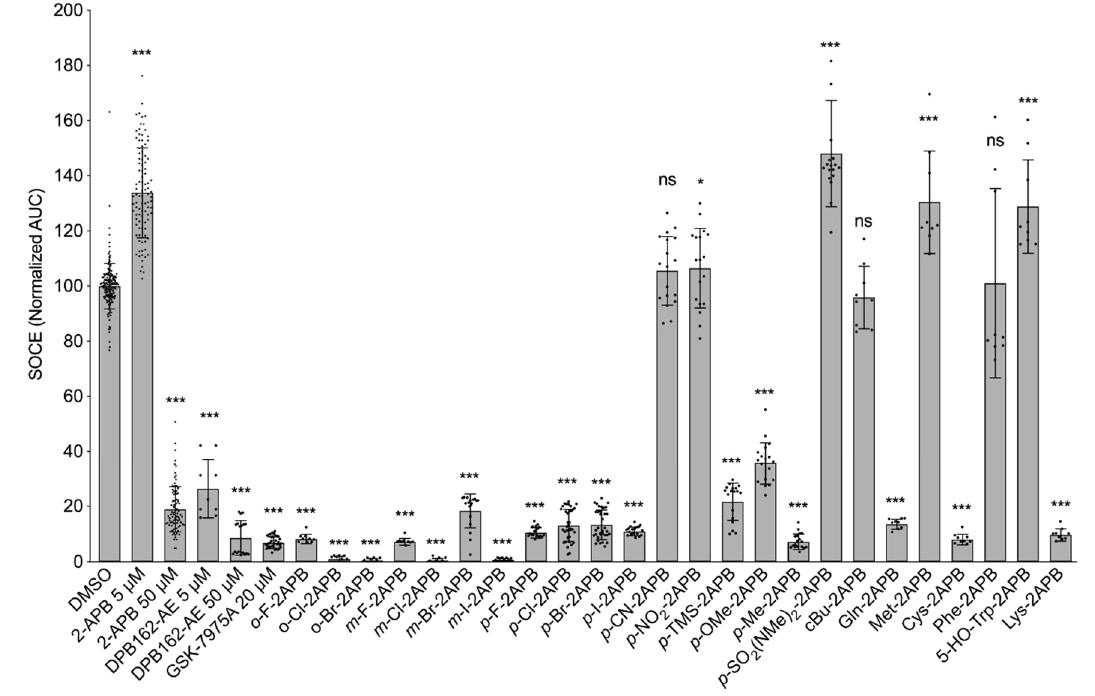
Figure 2. Screening of synthetic 2-APB analogues on SOCE in MDA-MB-231 cells using the FLIPR-based SOCE assay. Quantification of calcium influx after CaCl 2 application (AUC), normalized to DMSO control ( n ≥ 9 for all data points). Data shown are mean ± SD. All compounds were tested at 50 µM concentration, unless otherwise noted. Statistical significance compared to DMSO control is indicated as “***” for p ≤ 0.001, “*” for 0.01 < p ≤ 0.05 and “ns” not significant for p > 0.05.